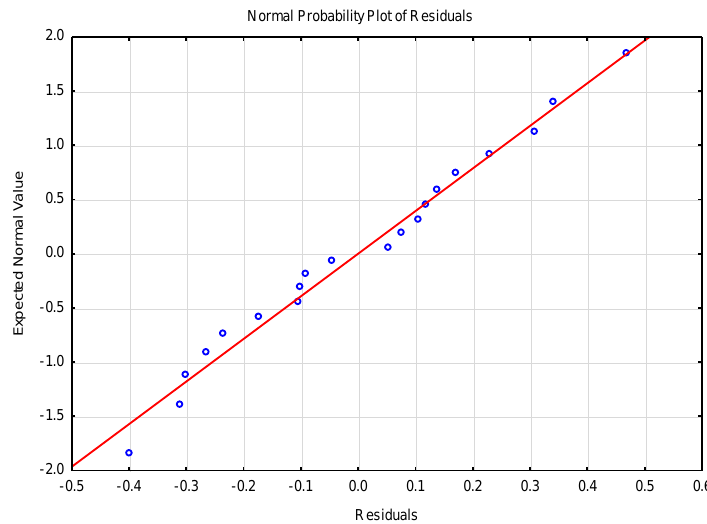
Figure 23. The normal plot of residuals for ∆ Ra / Ra .